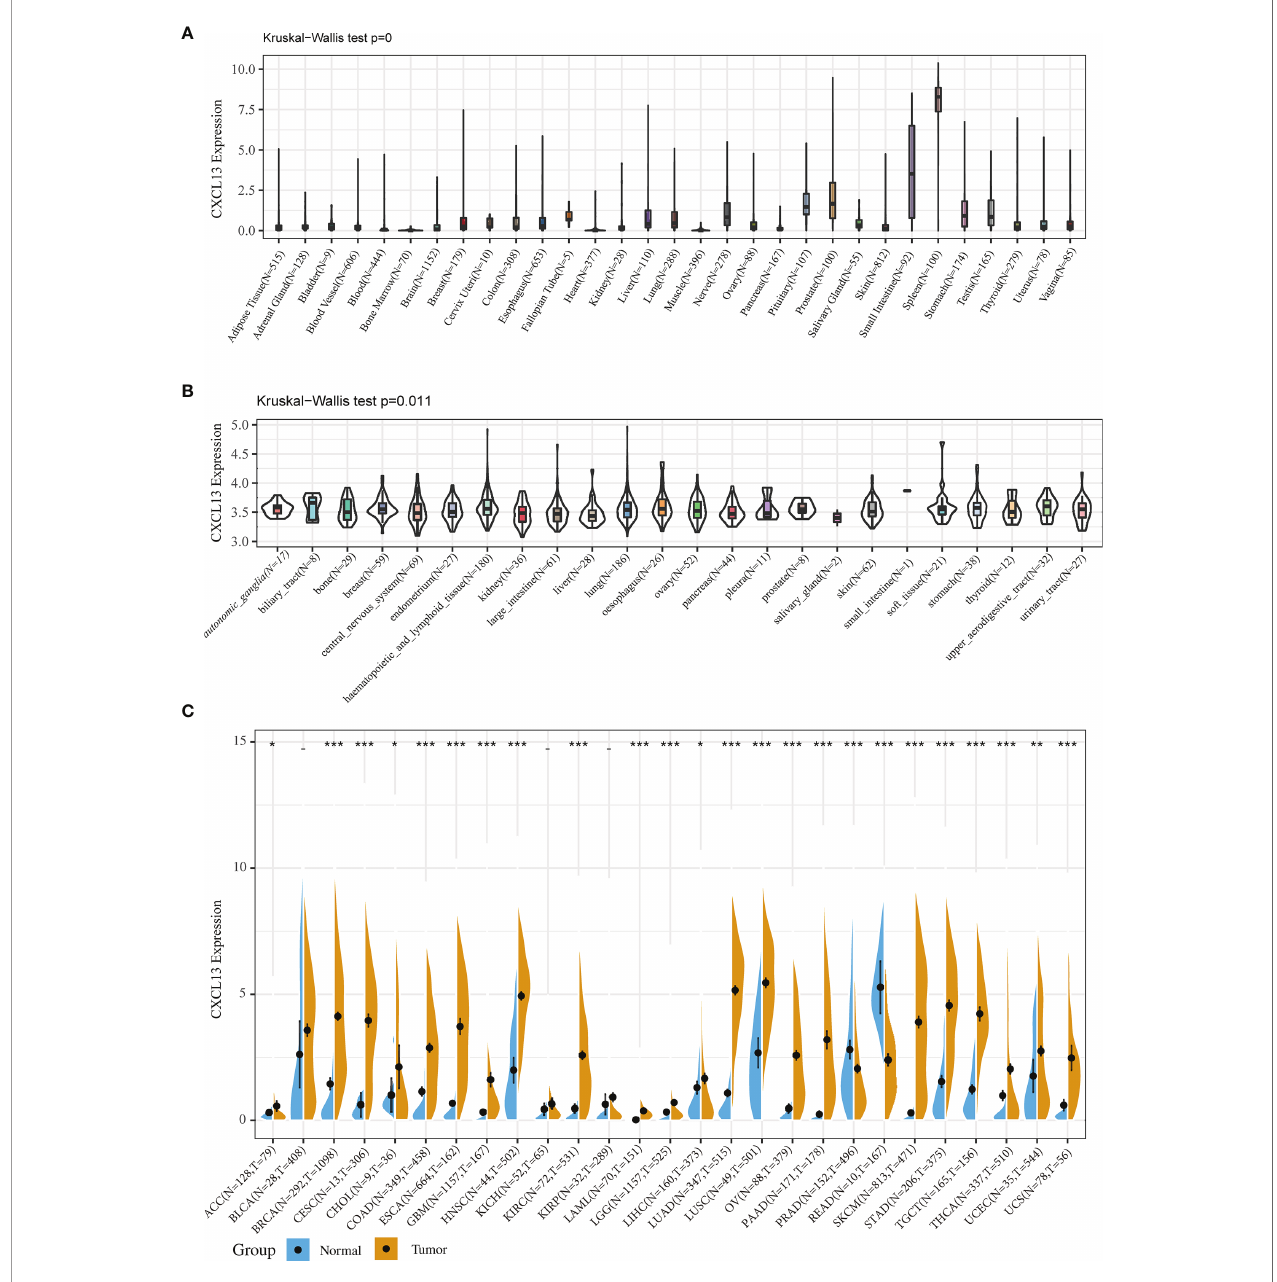
FIGURE 1 | CXCL13 expression in normal tissues and tumors. (A) CXCL13 expression in 31 normal tissues from the GTEx database. (B) CXCL13 expression in 21 cancer cell lines from the CCLE database. (C) CXCL13 expression in 27 cancer types from the GTEx database and TCGA database. *P < 0.05, **P < 0.01, ***P <